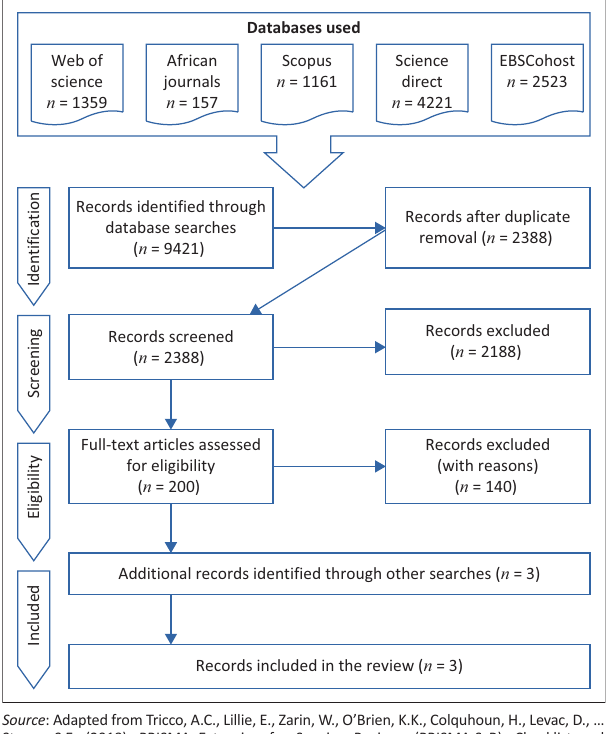
FIGURE 1: Diagram depicting the scoping review process followed by the